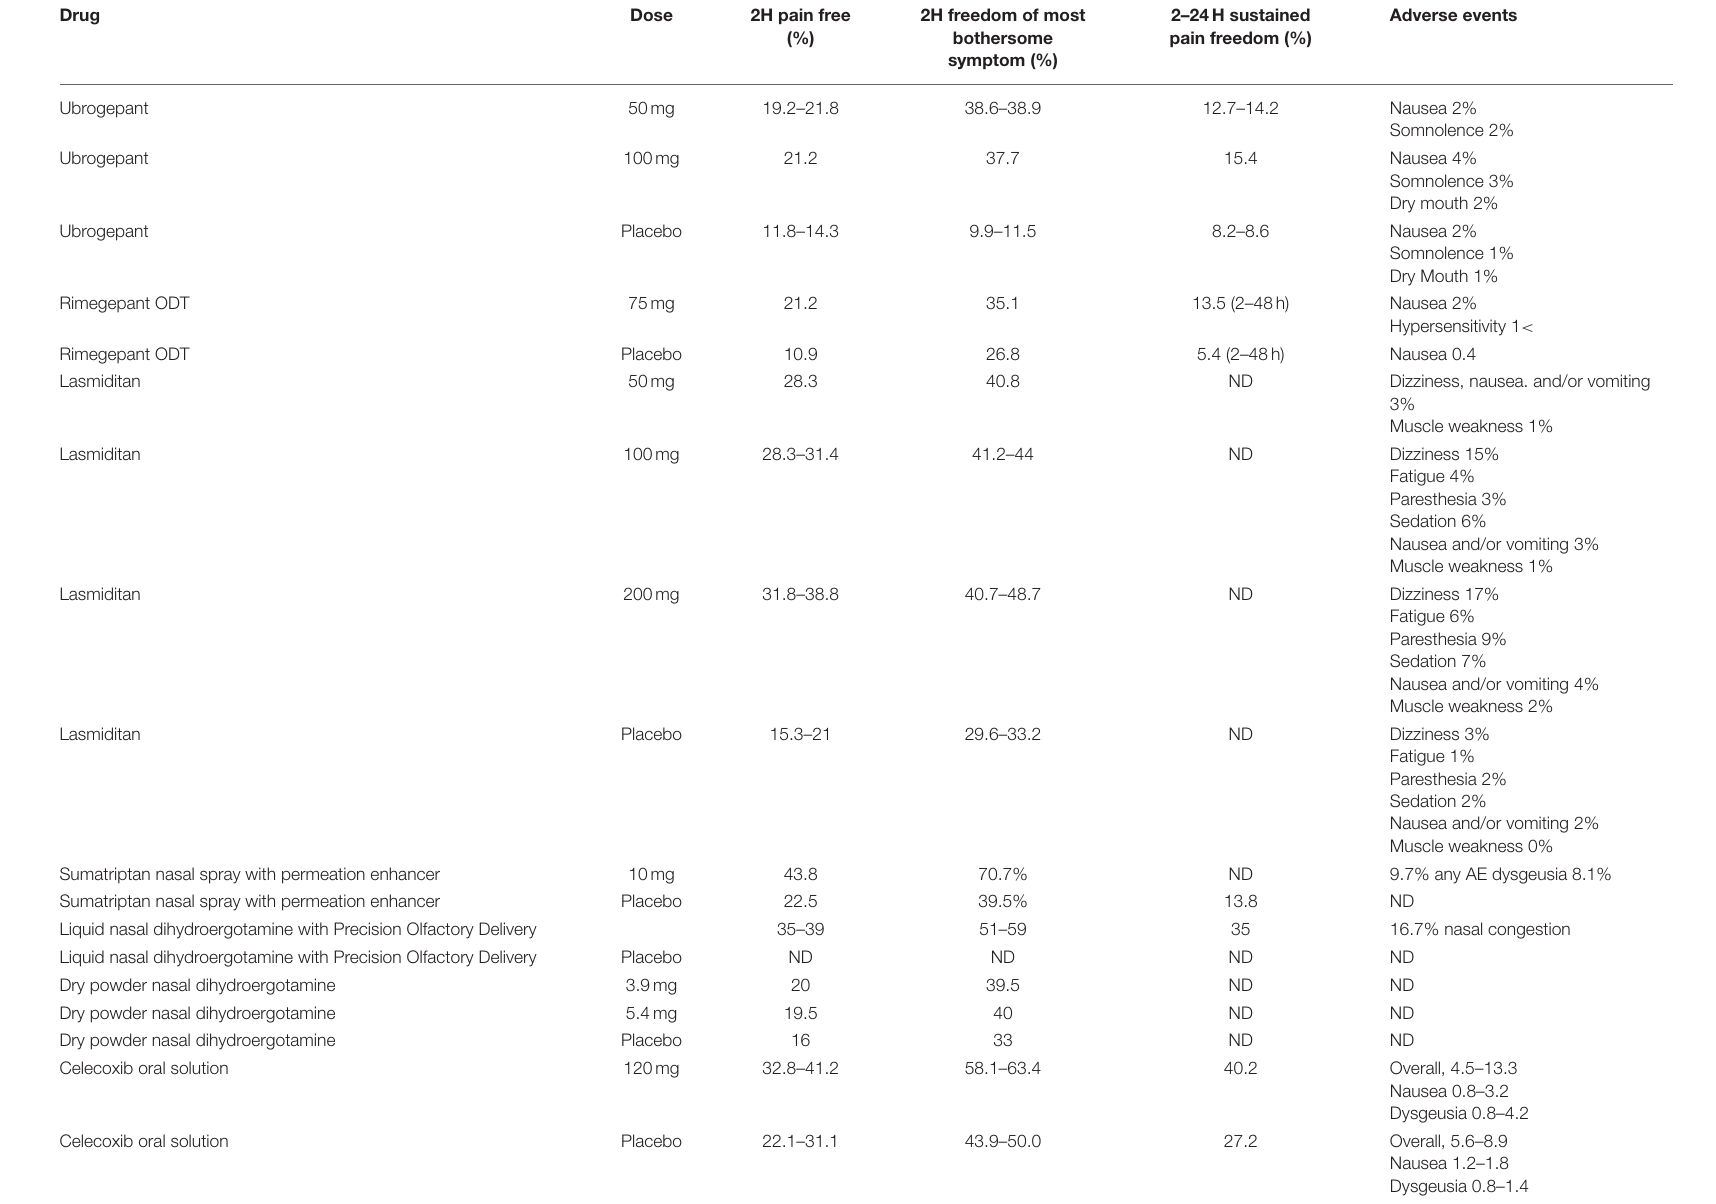
TABLE 1 | Efficacy and tolerability of acute treatment